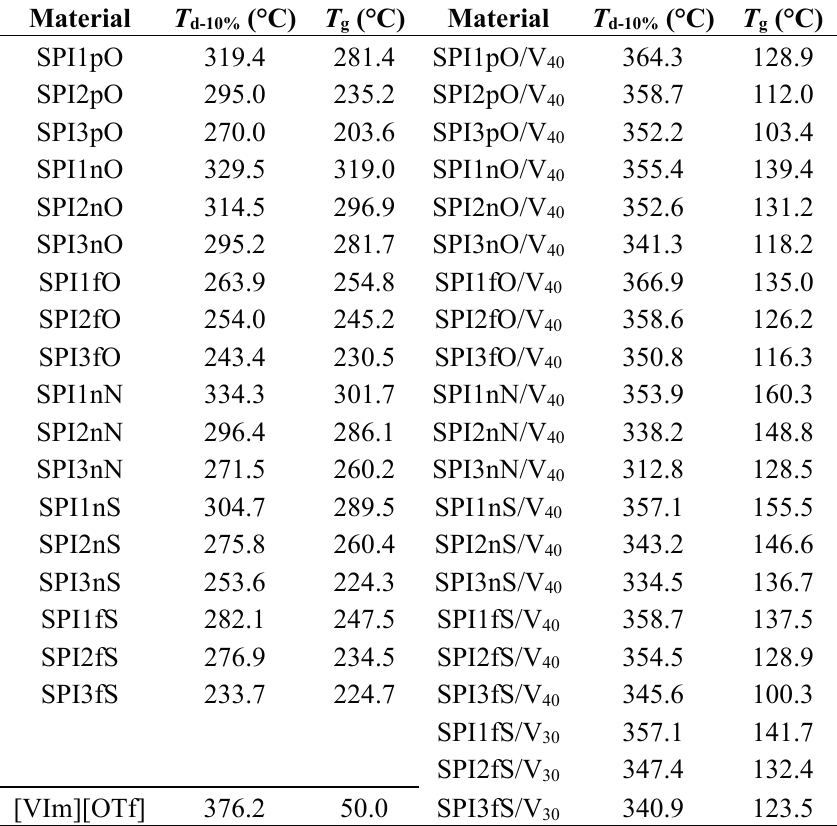
Figure 4. TGA scans of SPI, PIL and SPI/PIL composite membranes. Table 3. Thermal properties of SPIs, PIL and SPI/PIL composite